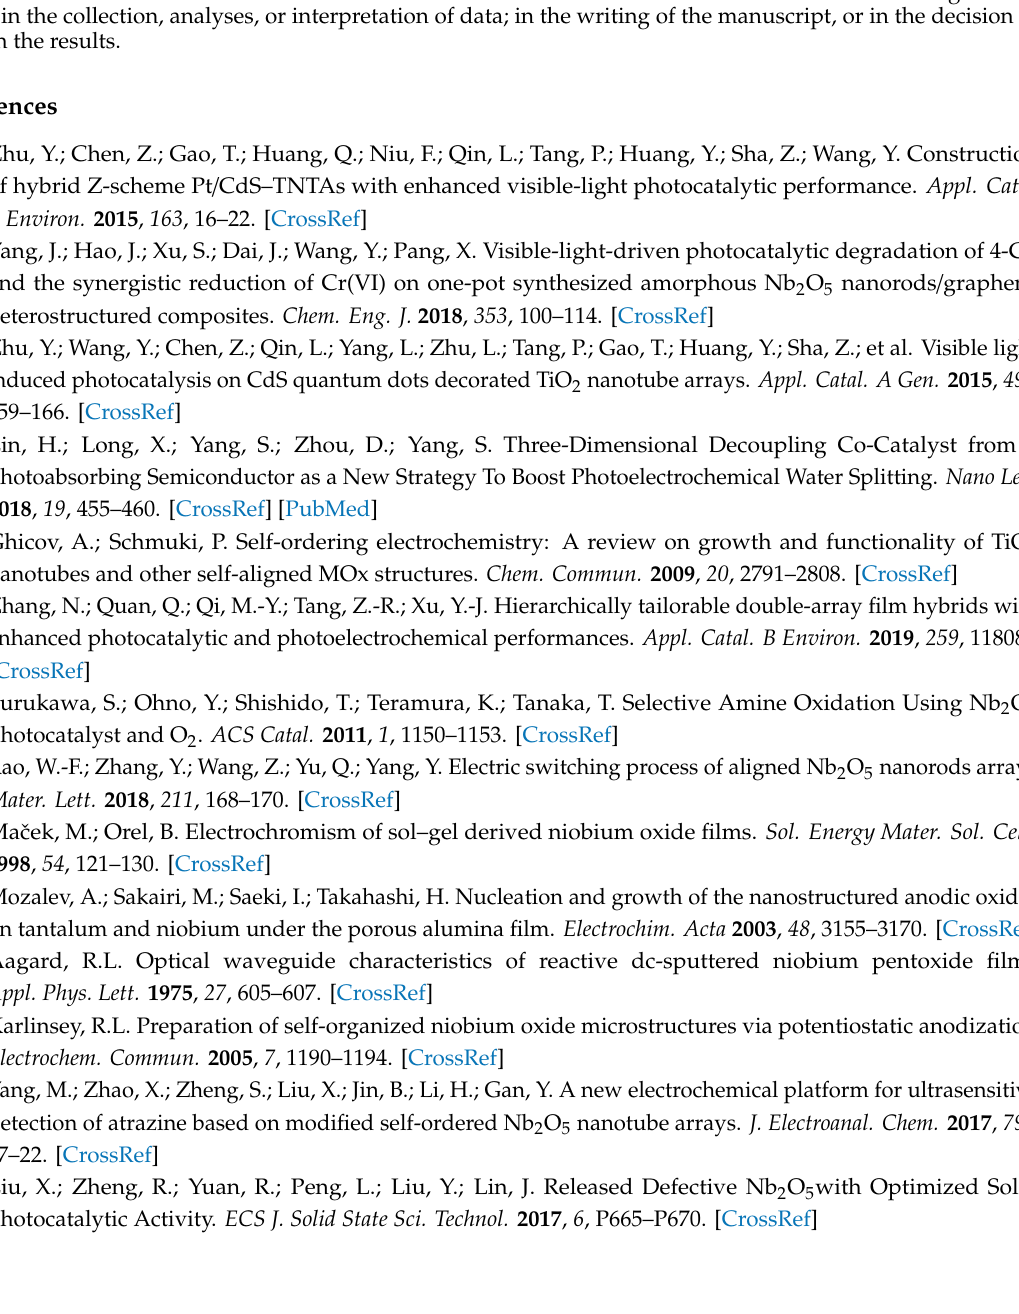
Figure S1: SEM images for the thickness of the oxide layer in stage II, Figure S2: High-resolution SEM images of the anodic oxide layers formed by anodization of Nb foils at 20V in the ethylene glycol electrolytes with the concentrations of NH4F at 0.25(a), 0.3(b), 0.35(c), and 0.4(d) M NH4F;and the water contents in 0.35 M NH4F at 0.5(e), 1.0(f) and 2(g) vol%, Figure S3: Standard curve of Rhodamine B solution, Figure S4: Rh B degradation by di ff erent samples under dark conditions and UV irradiation by 300 watts xenon